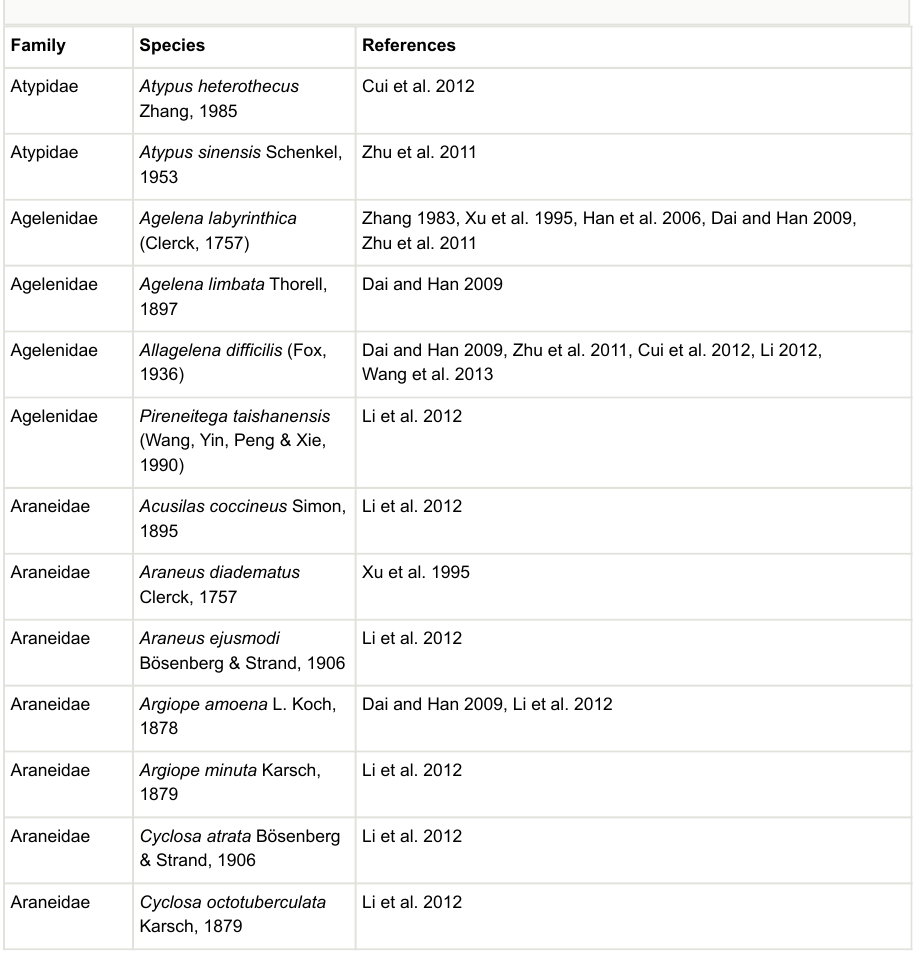
Dominant spider species in tea plantations of